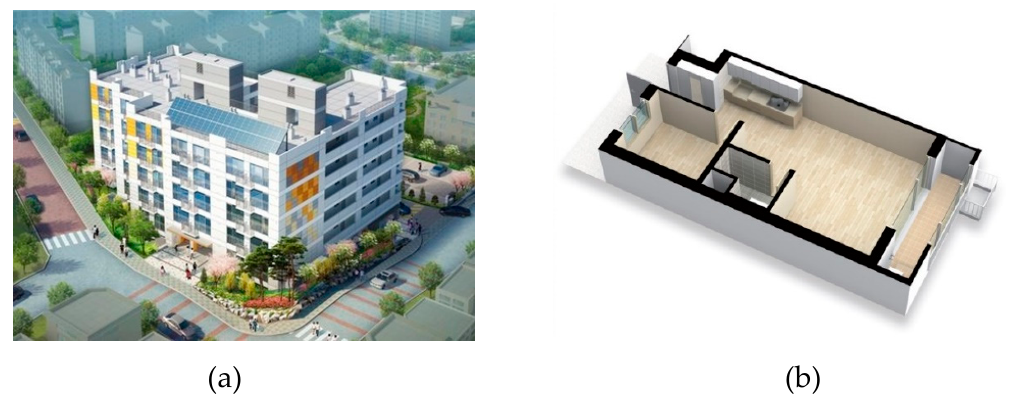
Figure 2. ( a ) Typical housing in the Republic of Korea [18]; ( b ) Typical housing layout for a one-person household [18].